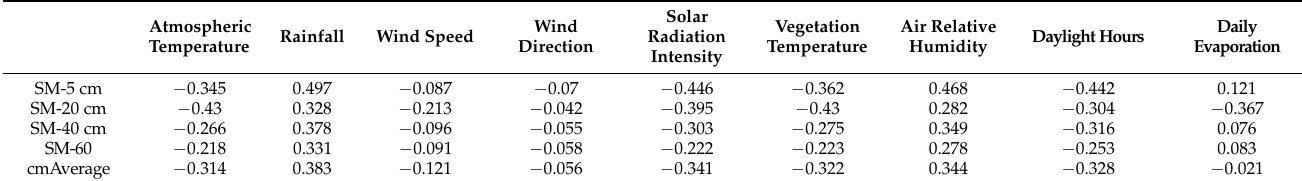
Table 6. Spearman correlation coefficients of environmental factors (Part II).